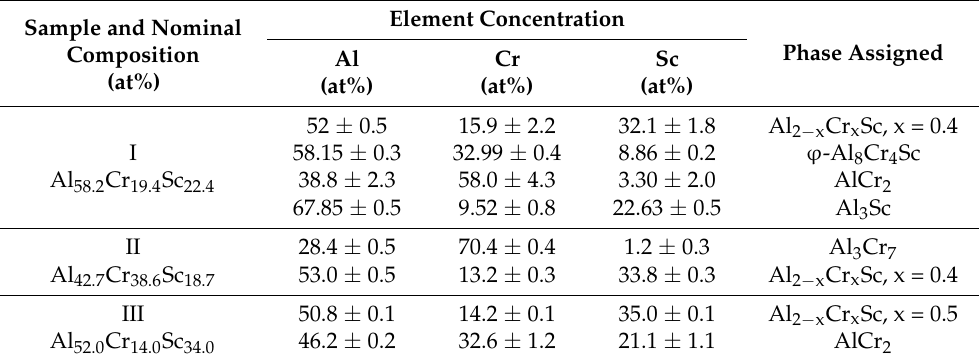
Table 2. Chemical compositions of the phases that were formed in our samples, with the correspond- ing experimental